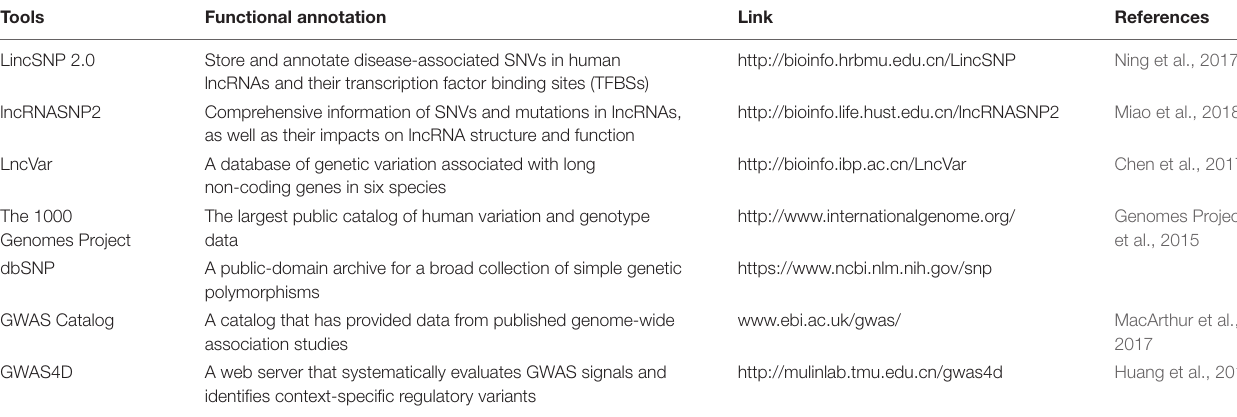
TABLE 3 | Some databases that may be used for driver